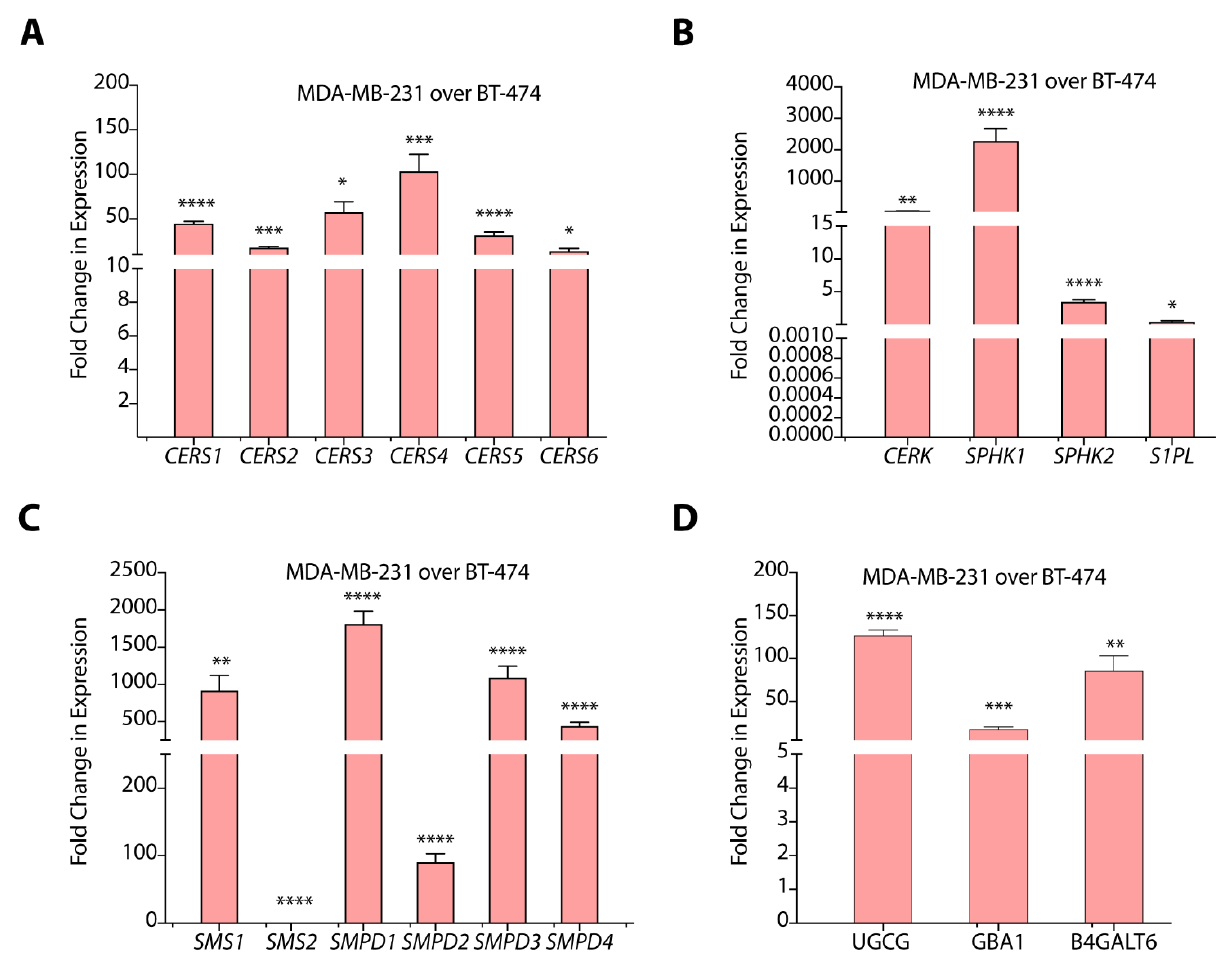
Figure 3. ( A – D ) Gene expression data of different sphingolipid-metabolizing genes in MDA-MB- 231 cells as compared to BT-474 cells. Data are presented as mean ± SEM of three independent rep- licates, and were analyzed by unpaired student’s t -test. p value: * p < 0.05, ** p < 0.01, *** p < 0.001, **** p <